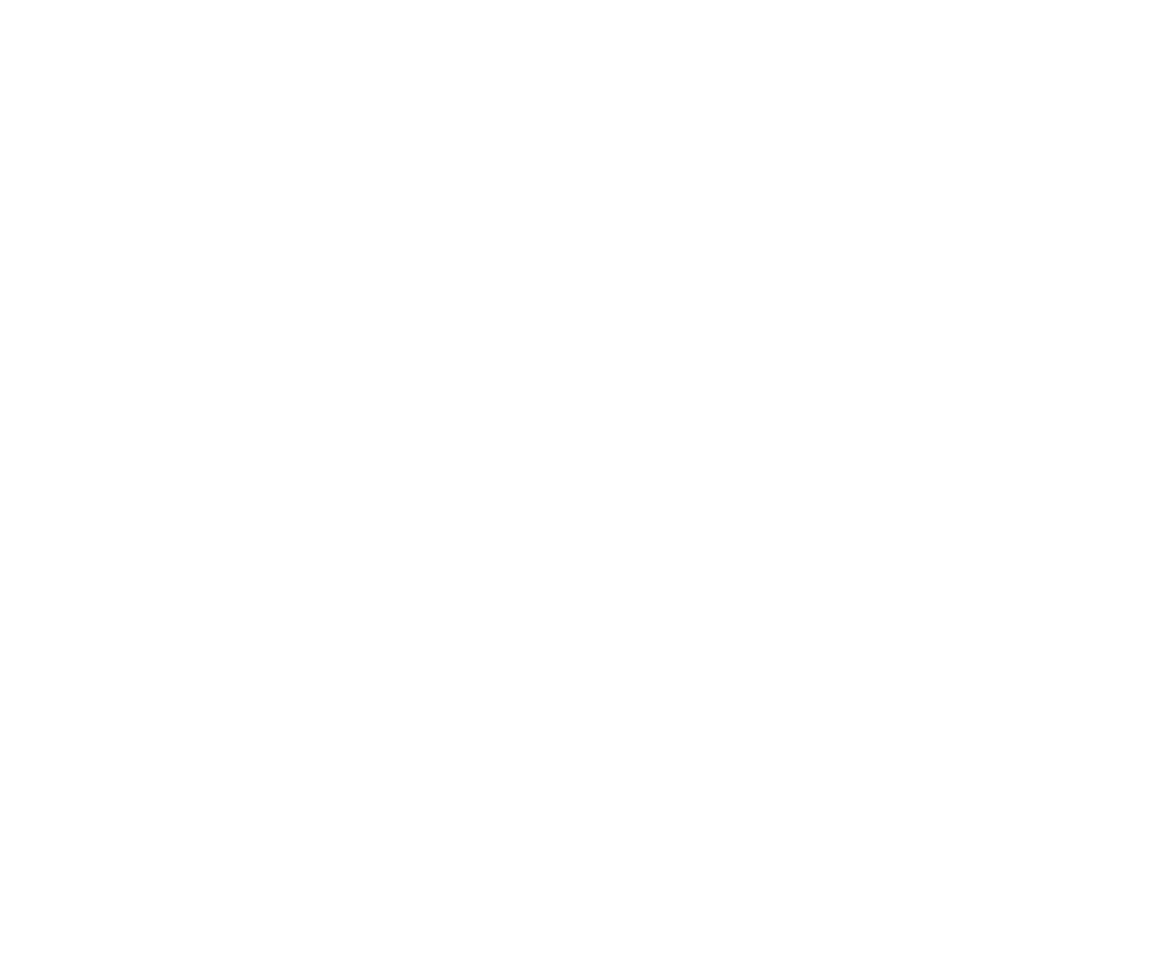
FiGuRE a1 | Subsequent-memory effects for OR faces, collapsed across the OR1 and OR5 conditions. (a) Waveforms for frontal electrode Fzp, frontocentral electrode Cza, and parietal electrode Pzs. (B) Topography